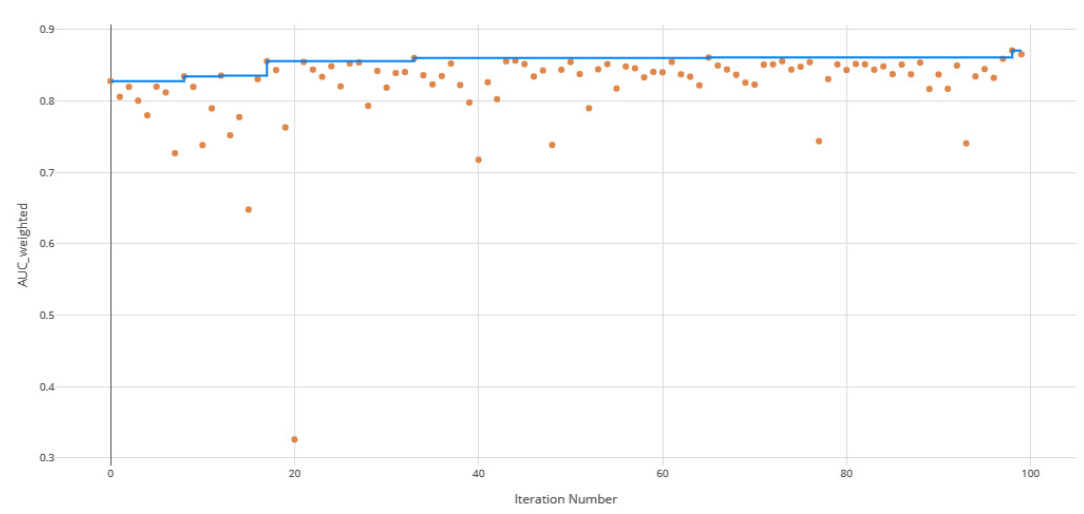
model.Figure 3. Area under the receiver operating characteristic curve (AUC) by iteration of the clearance rate model. Each orange dot is an iteration with the blue line representing the maximum AUC up to that iteration.